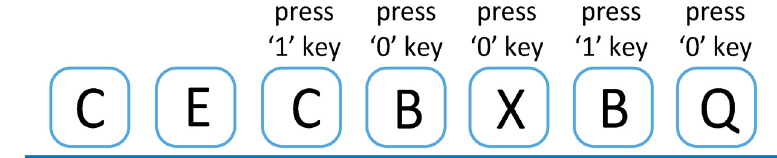
Figure 1. 2-back Experiment.